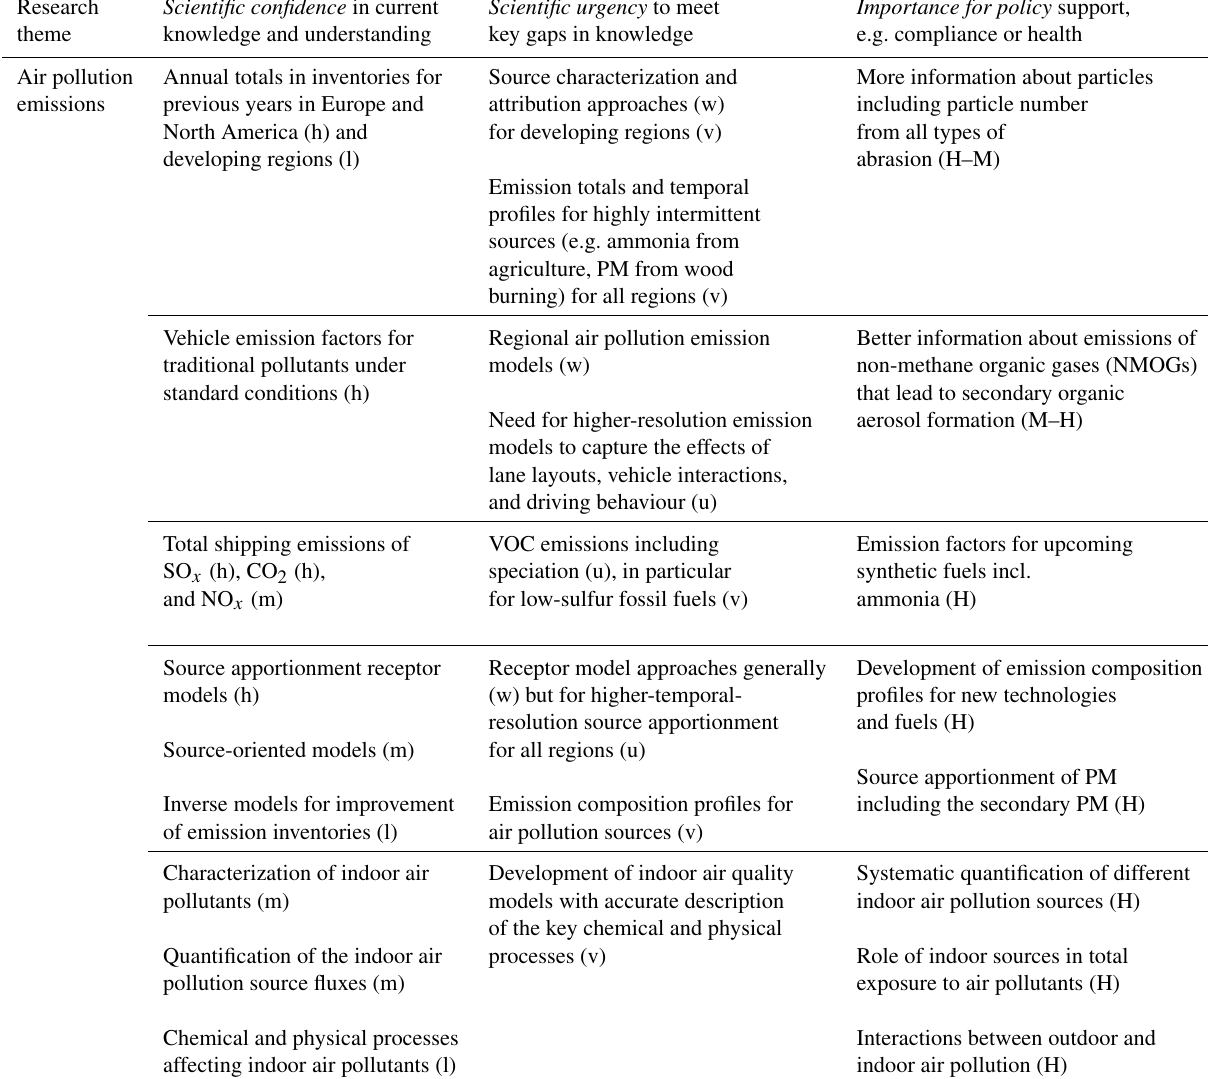
Table 1. A synthesis of key recommendations for scientific research and the importance for air quality policy. A three-level scale is used to indicate the current confidence in the scientific knowledge and understanding and a measure of the urgency to fill the science gaps where they exist. Similarly, a three-level scale is used to indicate the importance of the specific issues for policy support. Scientific confidence – h: high (progress is useful but may not require significant specific research effort); m: medium (some further research is required); l: low (concerted research effort is required). Scientific urgency to meet gaps in knowledge – v: very urgent need to fill science gap; u: urgent need to fill scientific gap; w: widely accepted with less urgency to fill the science gap. Importance for policy support – H: high (is highly important for developments of new policies); M: medium (can lead to refinements of current policies); L: low (progress is useful but may not require significant effort in the short or medium